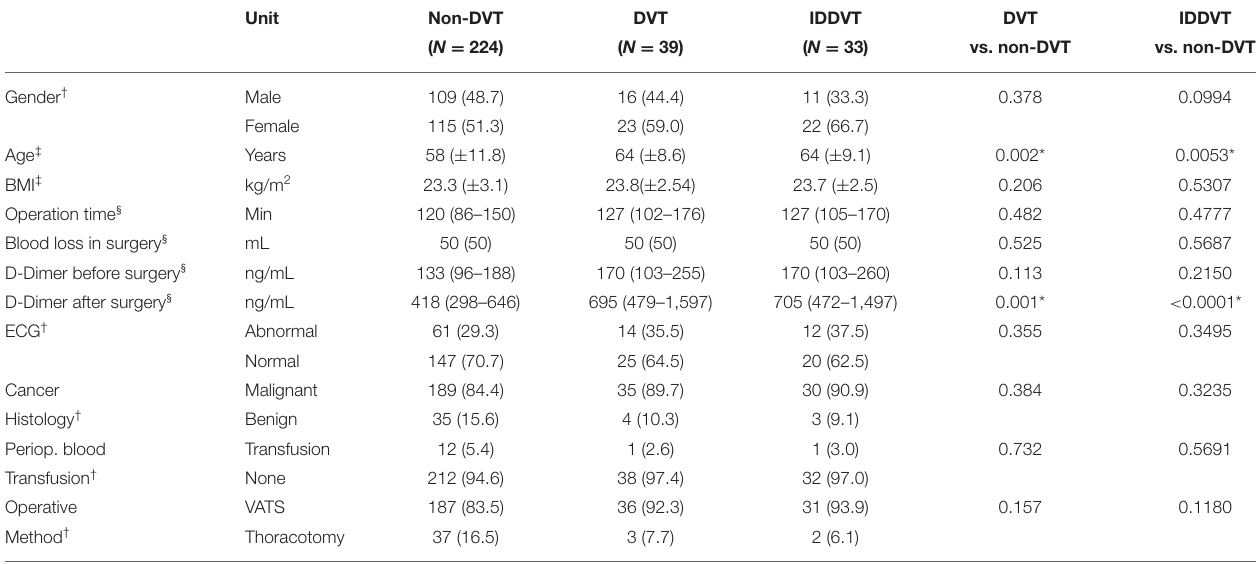
TABLE 2 | Descriptive statistics with comparison of IDDVT and non-DVT